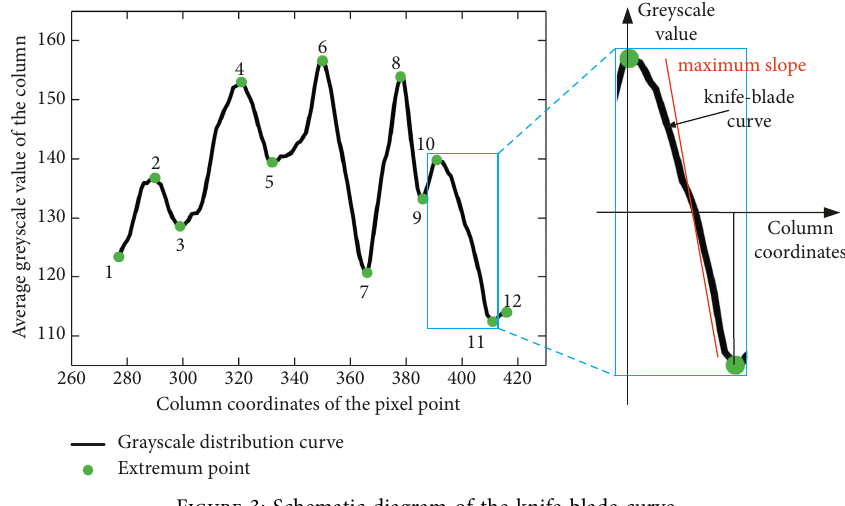
Figure 3: Schematic diagram of the knife-blade